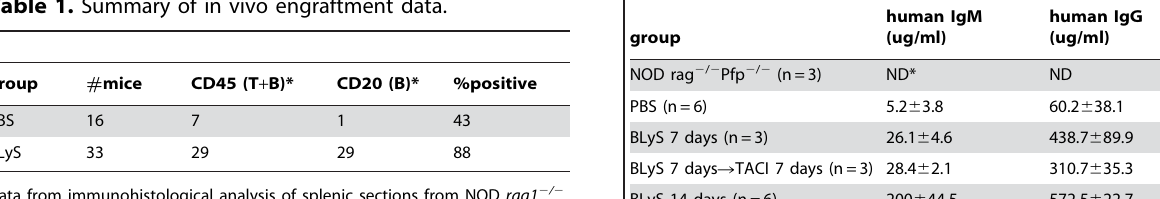
Table 1. Summary of in vivo engraftment data.